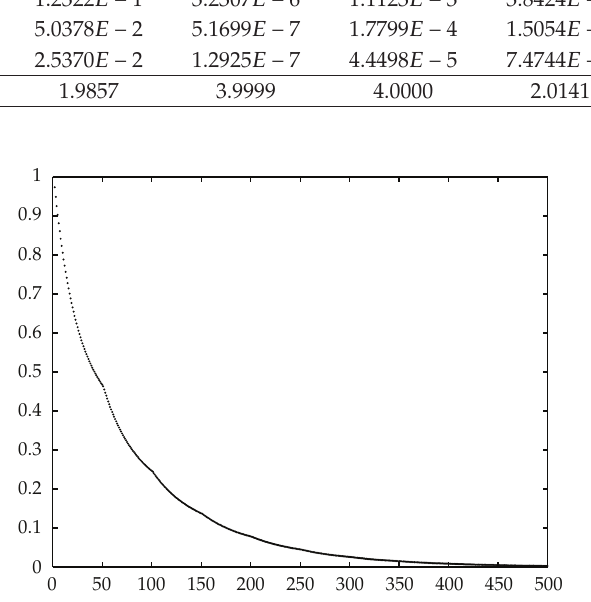
Figure 2: Linear θ -method with θ (cid:6) 1 / 2 for (cid:4) 5.1 (cid:5)